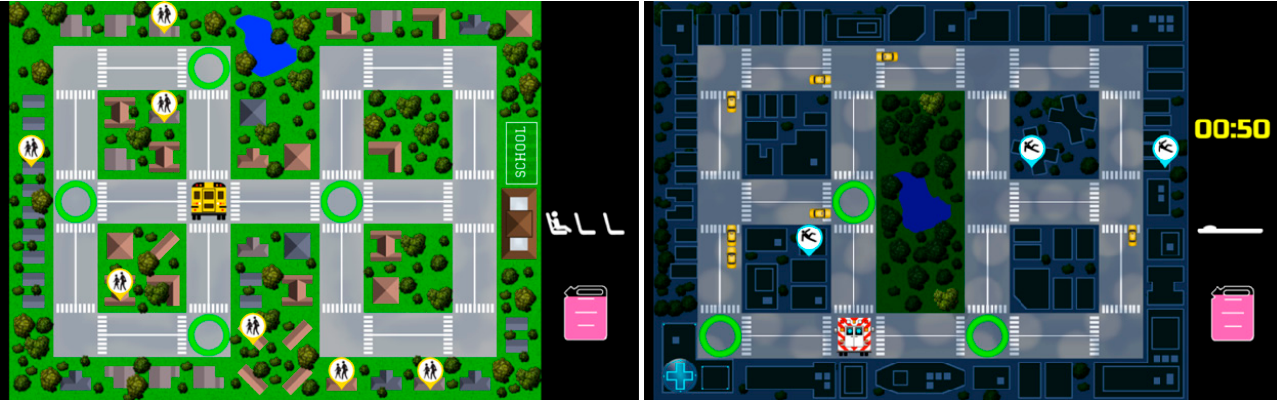
Figure 1. Screenshots of two high cognitive load tasks from the School Bus (left) and Ambulance (right) scenarios.